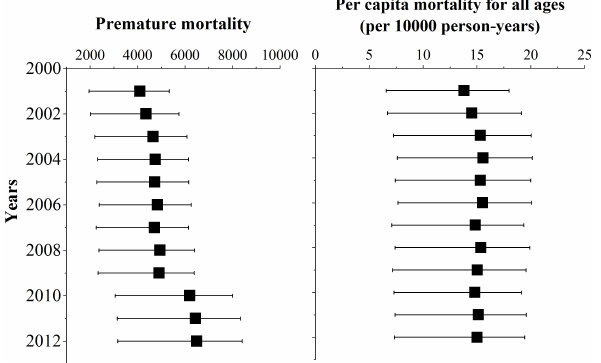
Figure 9. Annual premature mortality attributable to PM 2 . 5 and the per capita mortality for all ages for the period 2001–2012 in the Beijing central area, as well as the corresponding